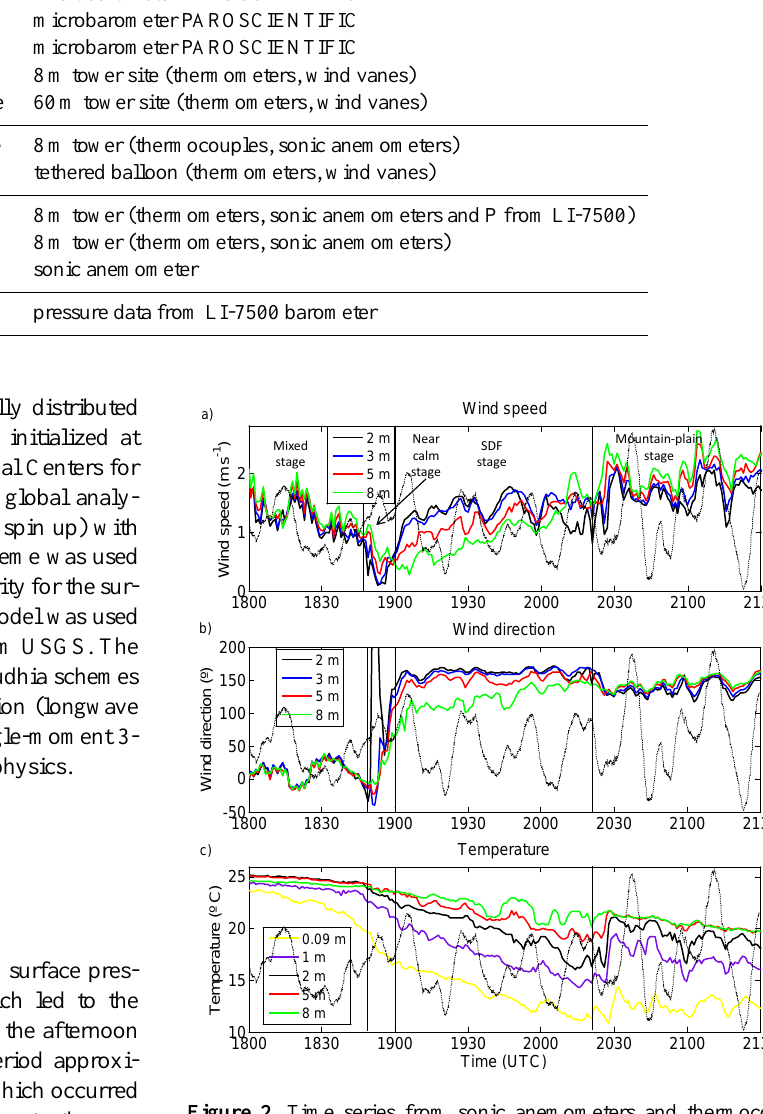
Figure 2. Time series from sonic anemometers and thermocou- ples measurements at the divergence site. (a) Wind speed (ms − 1 ). (b) Wind direction ( ◦ ). (c) Temperature ( ◦ C). Note that filtered sur- face pressure from the micro A site is overlaid for reference with a thin dotted black